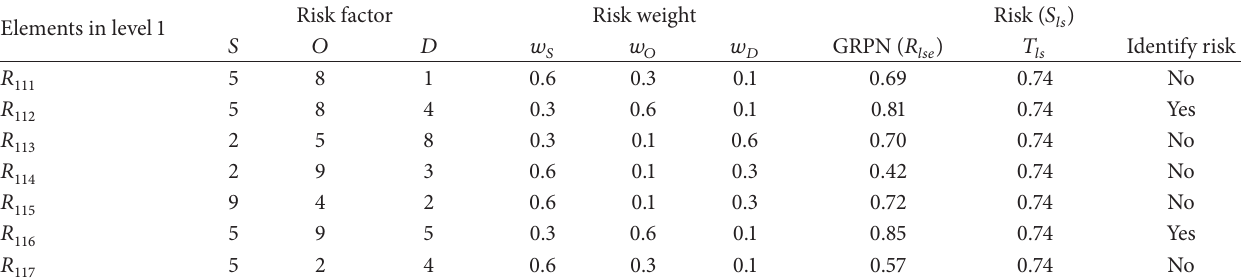
Table 15: Adaptive risk identification with scenario of risk weight threshold: hetero-homo. Elements in level